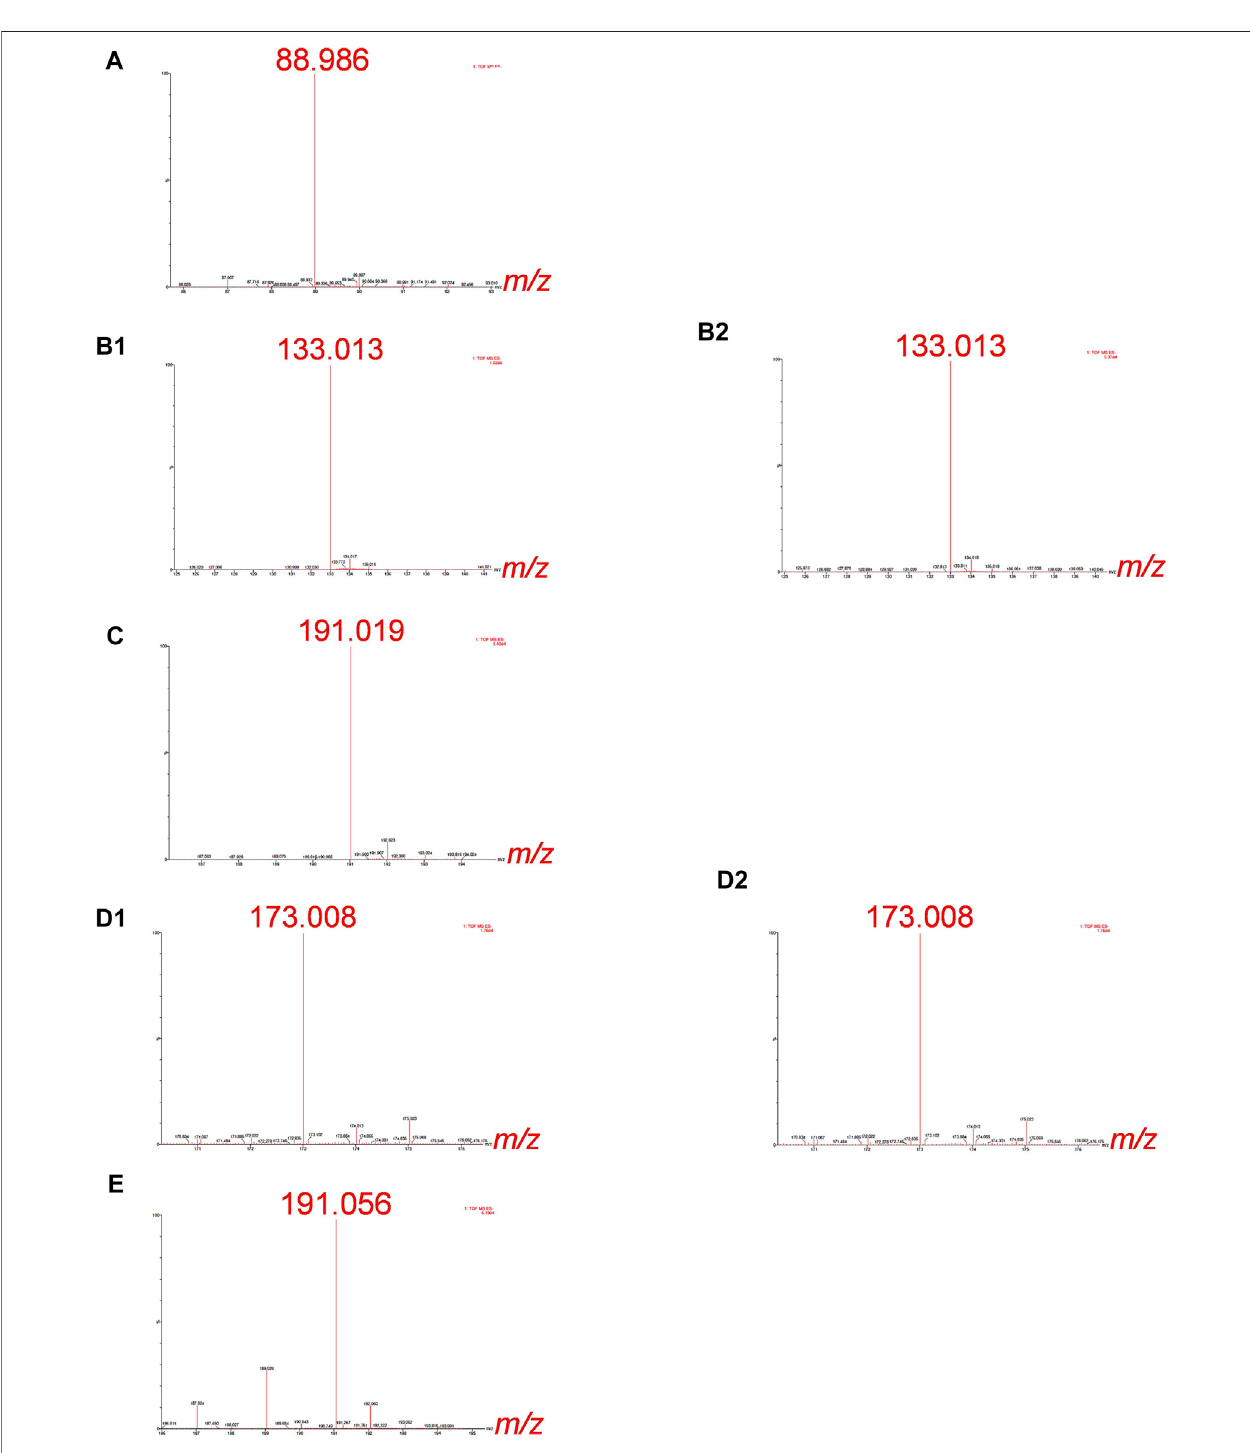
FIGURE 2 | HR-MS spectra of the Cr species eluted under the chromatographic peaks of synthetic solutions of (A) Cr-oxalate (3.3 – 4.5 min), (B1) Cr-malate (0.7 – 1.4 min), (B2) Cr-malate (5.0 – 5.6 min), (C) Cr-citrate (1.9 – 3.0 min), (D1) Cr-aconitate (2.1 – 2.9 min), (D2) Cr-aconitate (5.6 – 6.6 min), and (E) Cr-quinate (1.9 – 2.9 min). 10 µg ml − 1 Cr, Cr-to-ligand molar ratio for Cr-oxalate 1:10, and for Cr-malate, Cr-citrate, Cr-aconitate, and Cr-quinate 1:100, prepared in 0.013 mol l − 1 phosphate buffer (pH 6.5).